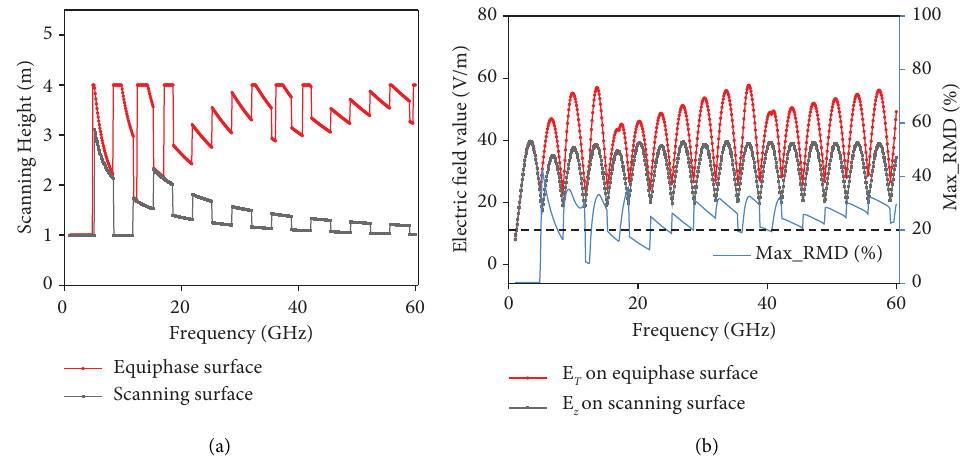
Figure 4: Results of a vertical dipole measured in a FAC: length h � 2U and distance d � 3 m. (a) Scanning height corresponding to the maximum electric feld on the two surfaces. (b) Te relative deviation of the maximum electric feld on the two